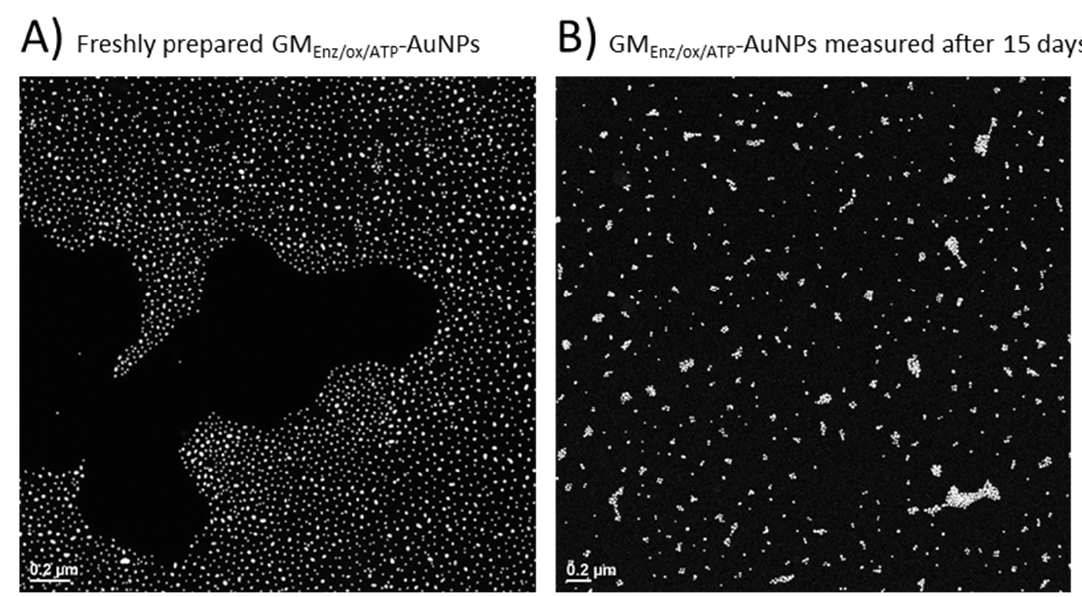
Figure 8. TEM images of gold particles upon functionalization with GM Enz/ox/ATP . ( A ) The image was taken withthe freshly prepared sample. ( B ) The image was taken after 15 days.